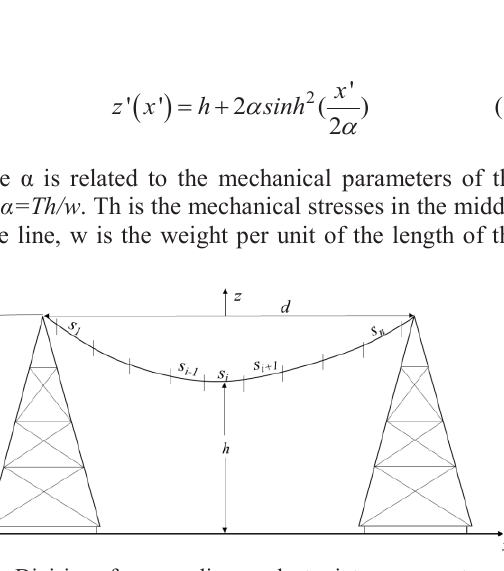
Fig. 1. Division of a power line conductor into n